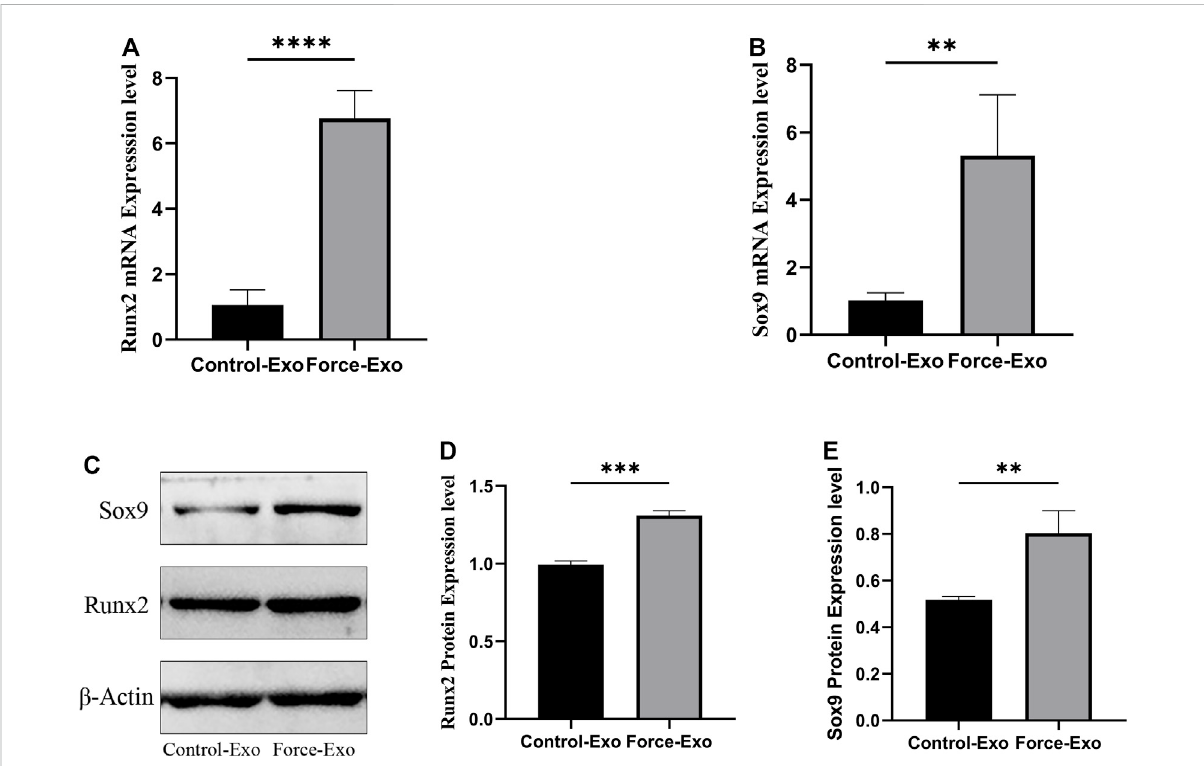
FIGURE 6 Force-Exo exosomes promoted osteogenic differentiation of condylar chondrocytes. (A) The expression level of Runx2 in condylar chondrocytes of the Force-Exo group was signi fi cantly higher than that in condylar chondrocytes of the Control-Exo group, **** p < 0.0001, N = 3 for each group. (B) The expression level of Sox9 in condylar chondrocytes of the Force-Exo group was signi fi cantly higher than that in condylar chondrocytes of the Control-Exo group. ** p < 0.01, N = 3 for each group. (C) The expression levels of Runx2 and Sox9 proteins in condylar chondrocytesoftheForce-Exogroupweresigni fi cantlyhigherthanthoseincondylarchondrocytesoftheControl-Exogroup, (D,E) Thegrayvalues of the Runx2 and Sox9 western blot bands for the Force-Exo group were signi fi cantly higher than those for the Control-Exo group, *** p < 0.0005, ** p < 0.01, N = 3 for each